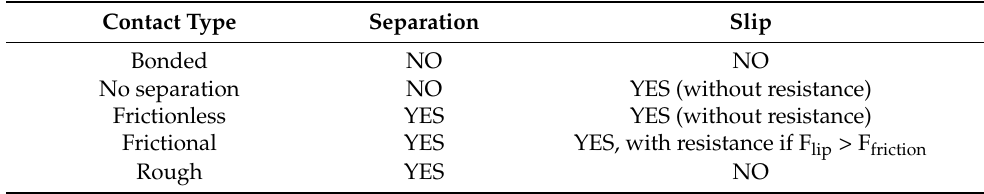
Table 2. Types of contacts in